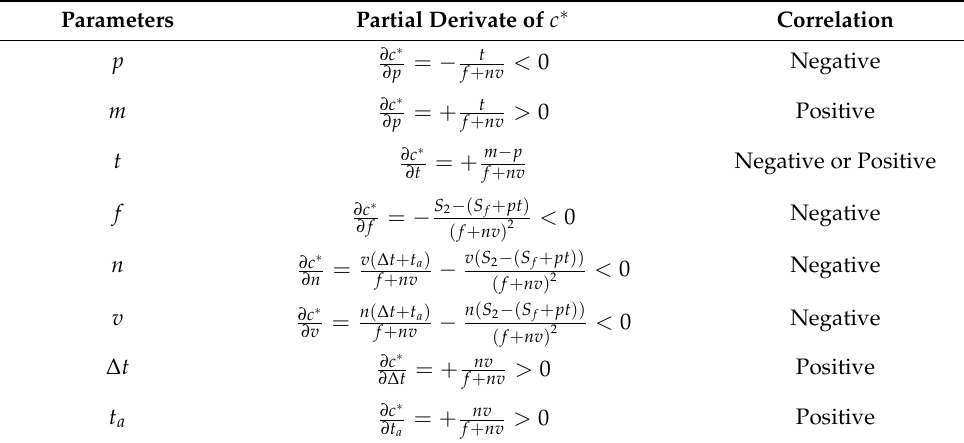
Table 2. Correlation between parameters of model and leverage of c ∗ .